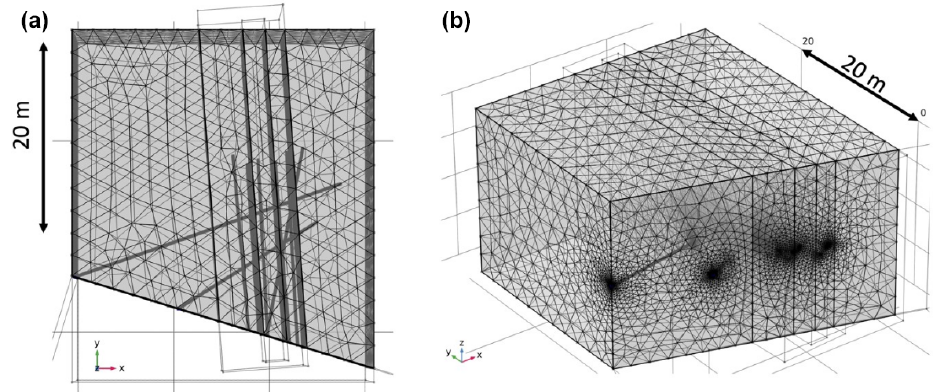
Figure 6. (a) bird-view and (b) side-view of the 3D domain used for the numerical simulation the thermal stimulation. Borehole and tunnel gallery East 03 locations correspond to their exact place as shown in Fig. 2.